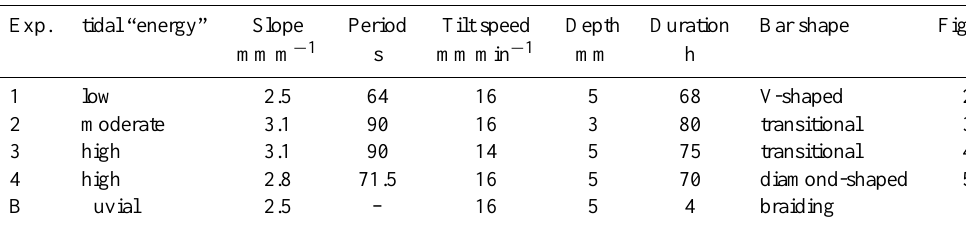
Table 1. Experimental settings. The delay between tilting phases was 2 s. The flume was 1.3m wide in Exp. 2 and narrowed to 1.0m wide in all other experiments. Exp.